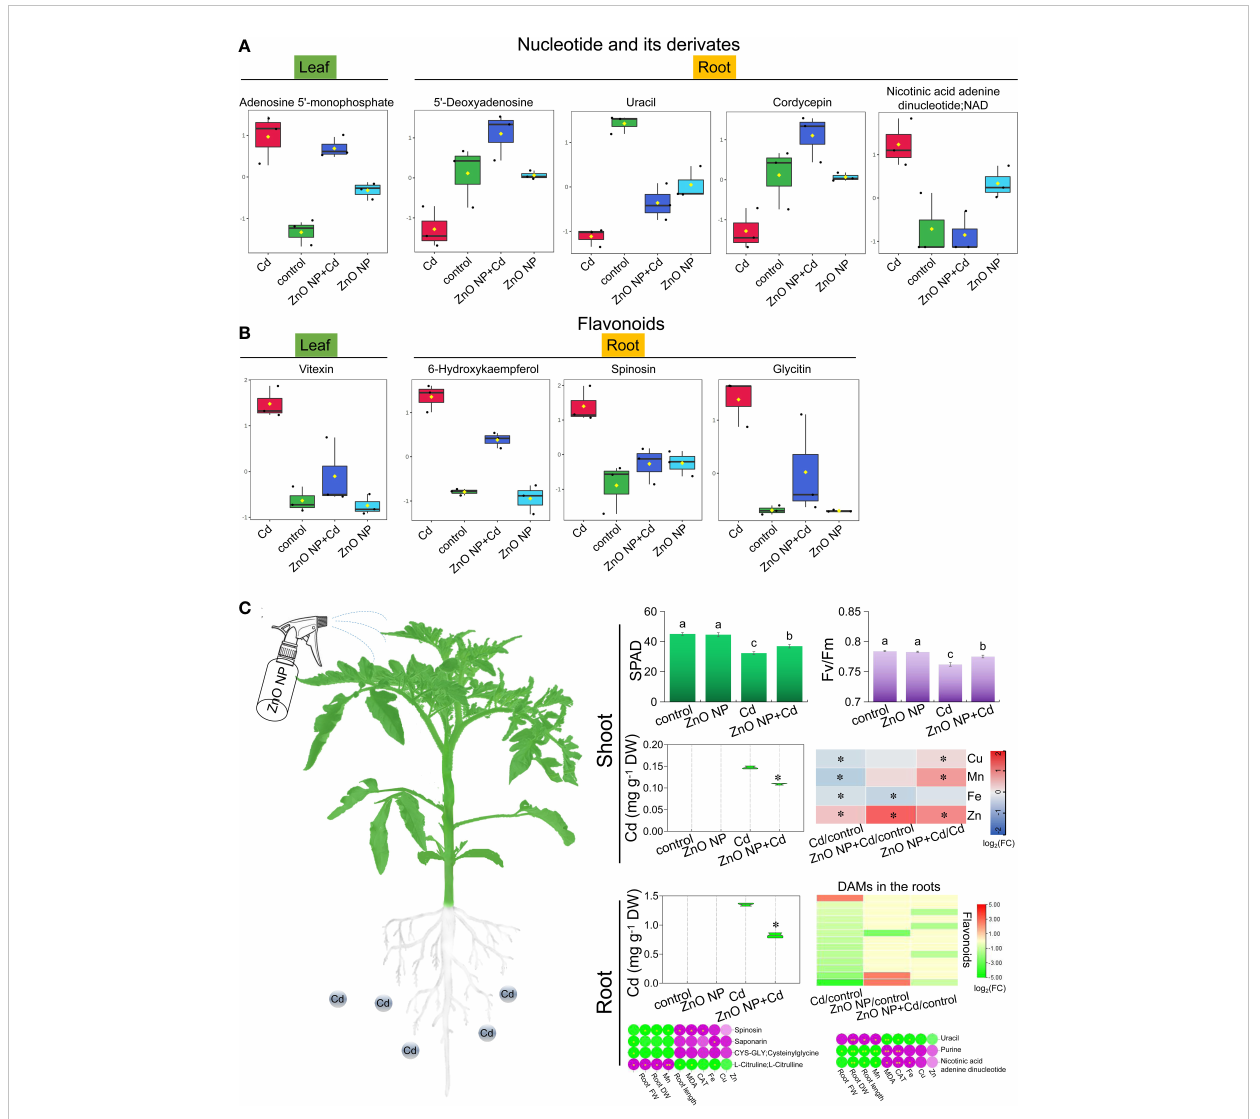
FIGURE 8 The differentially accumulated (A) nucleotide and its derivatives and (B) fl avonoids in the leaves and roots of tomato seedlings. (C) Mechanistic model of ZnO NPs alleviation of Cd stress in tomato seedlings. * indicates signi fi cantly different values at P < 0.05, ** indicates signi fi cantly different values at P < 0.01 according to Student ’ s t